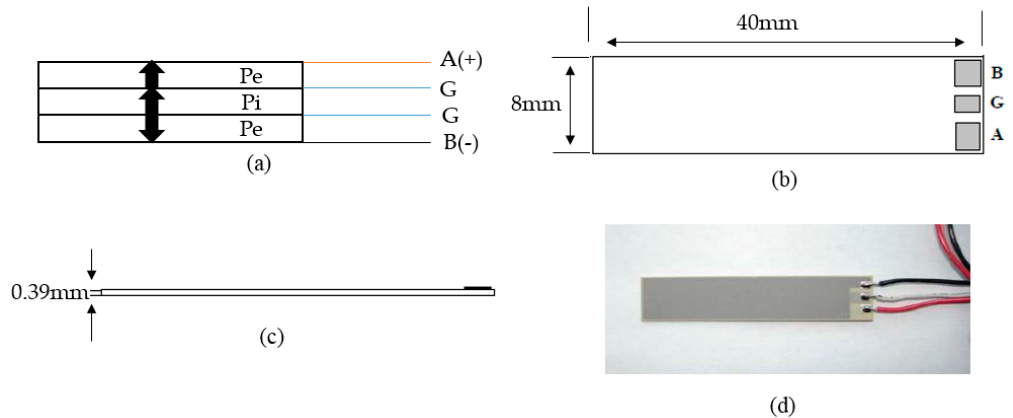
Figure 1. Results of bending simulations for a piezoelectric plate [(H) 40 × (W) 8 × (T) 0.4 mm)] with COMSOL Multiphysics: displacement ( μ m) in the z axis from a single layer to three layers (left) and the optimal ratio (Pi/Pe) for a three-layer bender to be bent most (right). A square wave (500 Hz, 20 Vpp) was applied to the piezo plate for simulations.